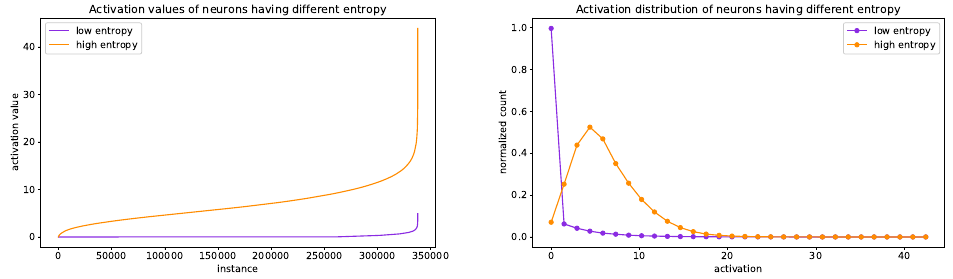
Figure 4. Activations of neurons having different entropies. In both the images, the purple line refers to a neuron having a low entropy score H = 1.06, while the orange line represents a neuron with an high entropy H = 5.19. The left figure is a simple plot of the sorted activation values for the two neurons, while the left figure reports the distribution of the activation